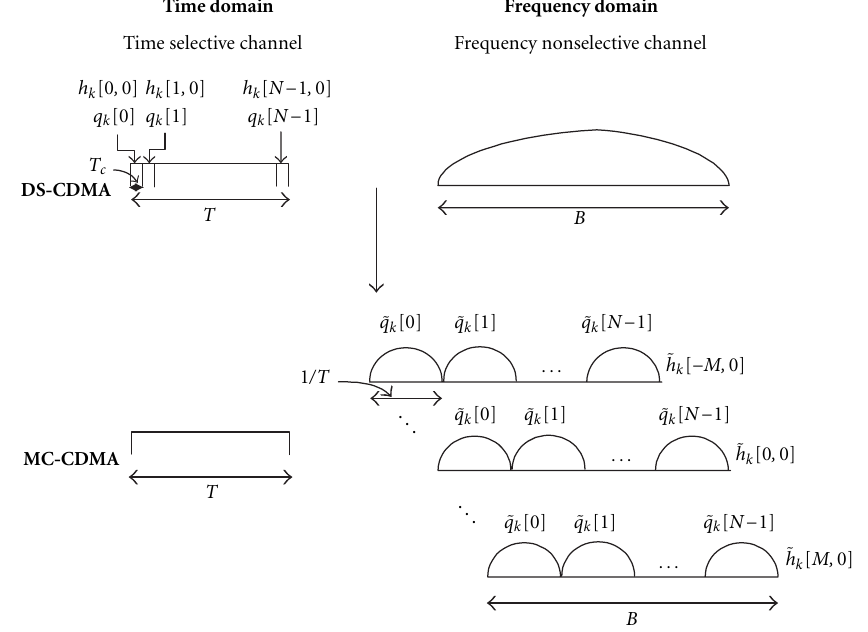
Figure 4: DS-CDMA and MC-CDMA systems in a TS channel. The MC-CDMA basis waveforms experience multiple Doppler dispersion in frequency due to time selectivity. The DS-CDMA system is diagonal since each basis waveform (chip) encounters nonselective fading in the time